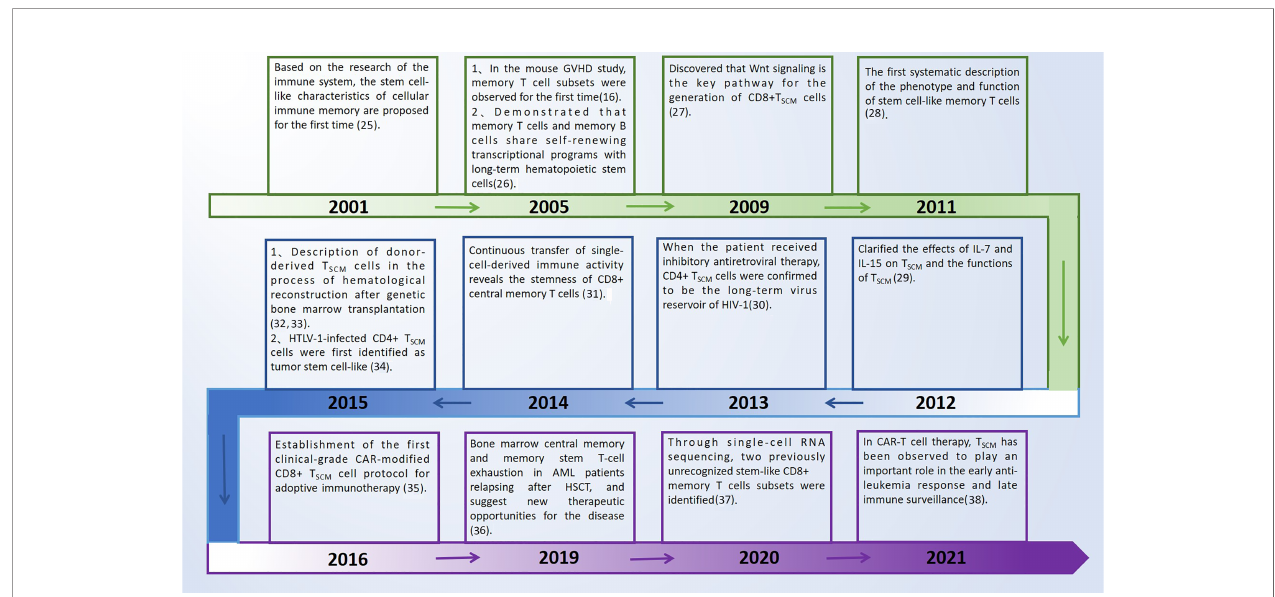
FIGURE 1 | Key discoveries on T SCM cells. GVHD, graft versus host disease; T SCM cells, T memory stem cells; HTLV-1, human T cell lymphotropic virus type 1; HIV-1, human immunode fi ciency virus type 1; CAR-T, chimeric antigen receptor-engineered T cells; AML, acute myeloid leukemia; HSCT, hematopoietic stem cell